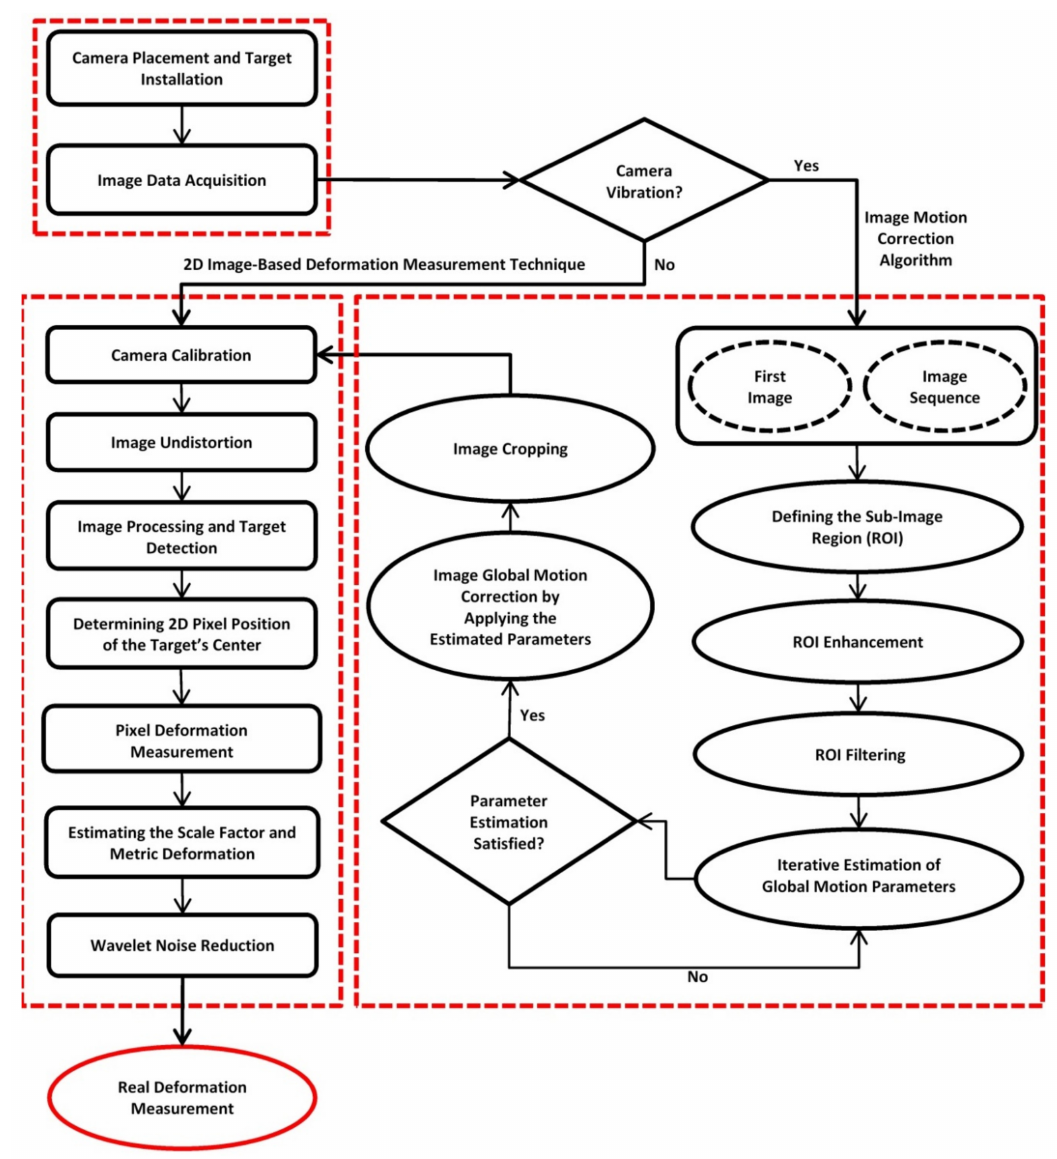
Figure 1. Schematic diagram of 2D image-based motion correction